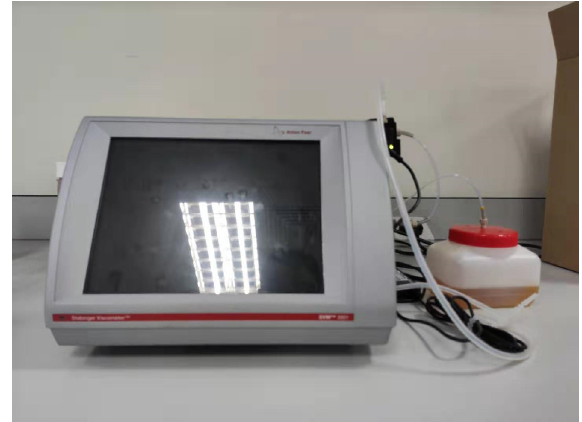
Figure 4. Anton Paar SVM model 3001.